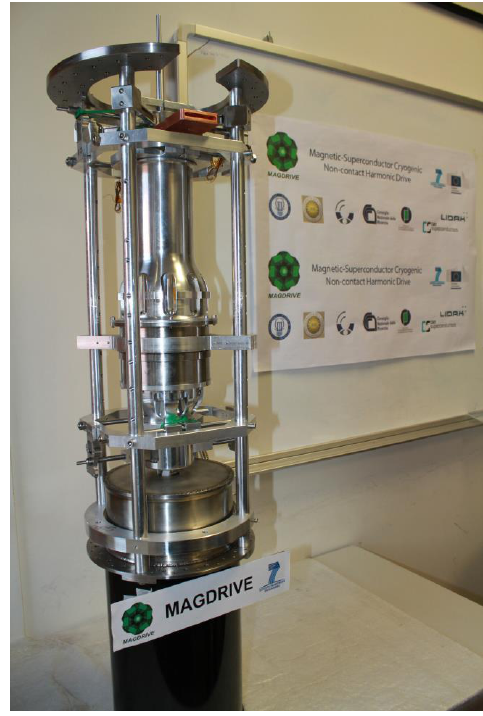
Figure 5. Assembly of the